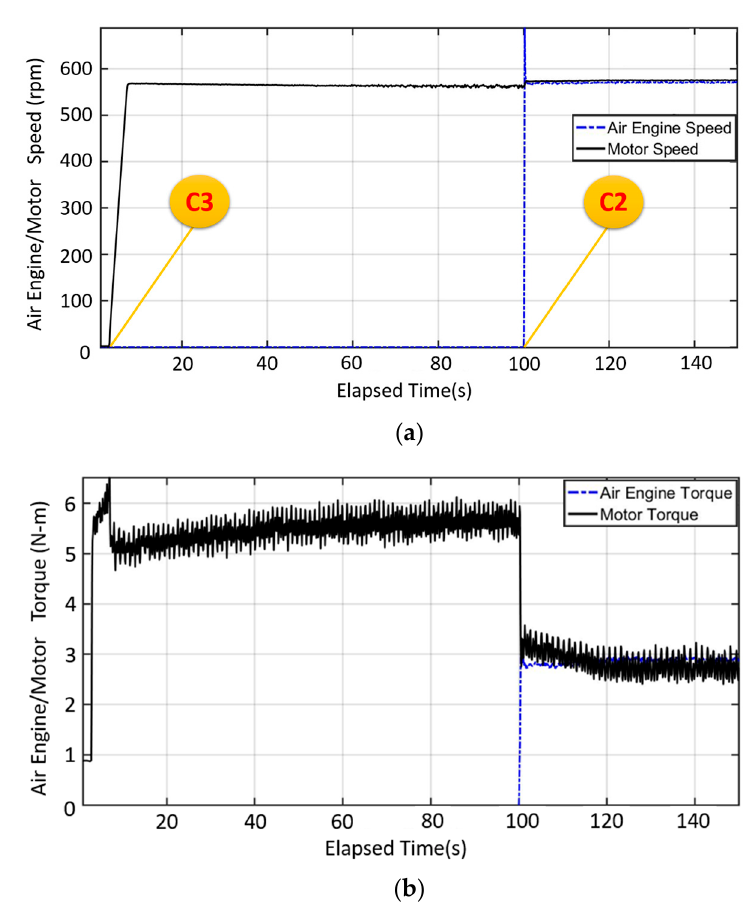
Figure 12. Hub motor/air engine hybrid mode: ( a ) speed; ( b ) torque .